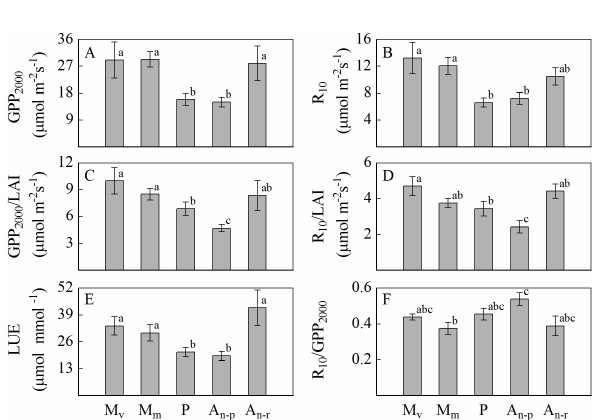
Fig. 6. Mean peak season values of ( A ) gross primary productivity per unit ground area at a photon flux density of 2000µmolm − 2 s − 1 (GPP 2000 ) , ( B ) ecosystem respiration at a reference temperature of 10 ◦ C (R 10 ) , ( C ) GPP 2000 per unit leaf area, ( D ) R 10 per unit leaf area, ( E ) light use efficiency (LUE), ( F ) R 10 /GPP 2000 at op- timum LAI based on all field campaigns across all study years. Sites are indicated as: M v (valley bottom meadow), M m (mountain meadow), P (pastures), A n − r (nutrient-rich abandoned grassland), A n − p (nutrient-poor abandoned grassland). Significantly different means are indicated by different letters (oneway ANOVA).